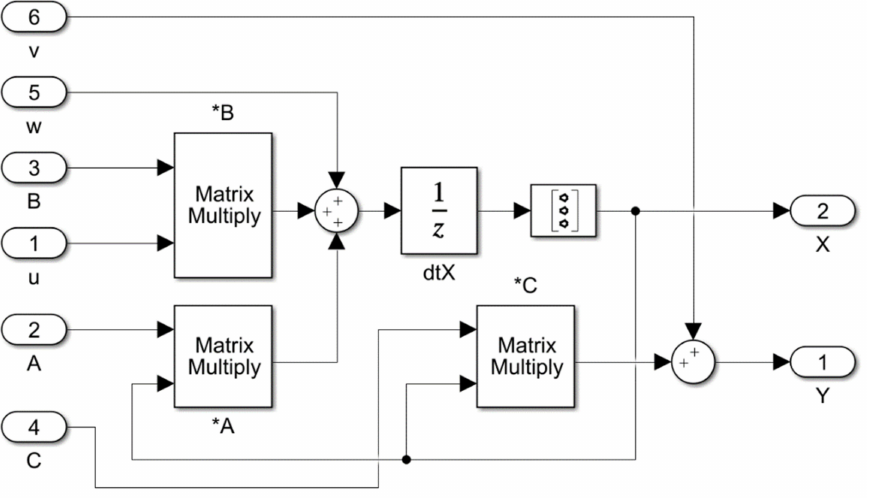
Figure 14. Created model of longitudinal movement of UAV including noise.